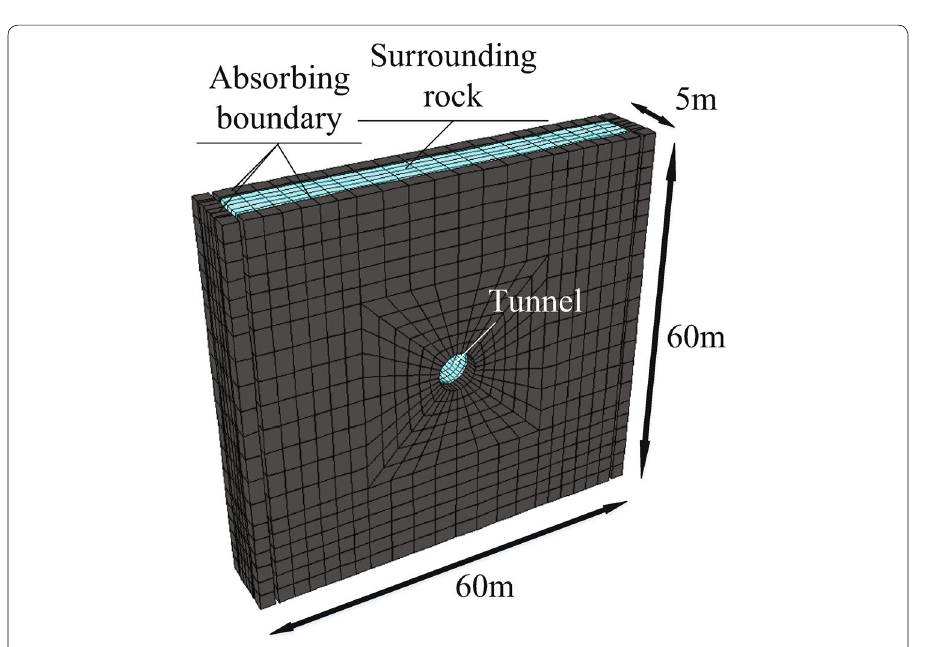
Fig. 4 Numerical model in